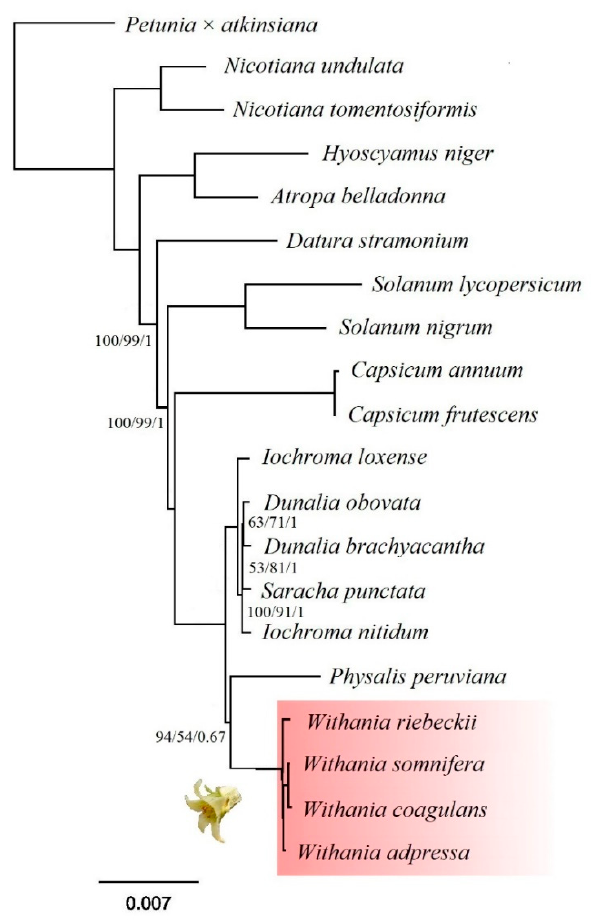
Figure 9. Maximum likelihood (ML) tree reconstructed among 19 species of Solanaceae based on 74 protein-coding genes. Bootstrap, SH-aLRT values and Bayesian posterior probabilities are indicated at each node as UFBoot / SH-aLRT / PP. Unmarked nodes have maximum support values. The scale bar is proportional to substitution per site.